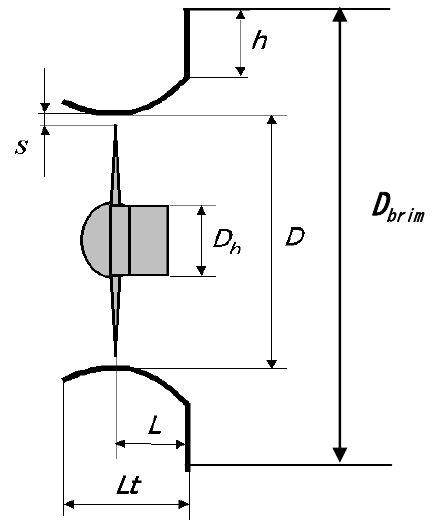
Figure 8. Schematic of wind-lens turbine.